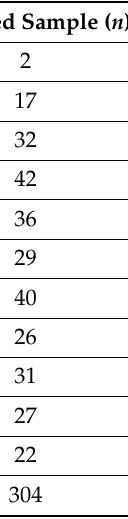
Table 1. Estimation of the sample size.